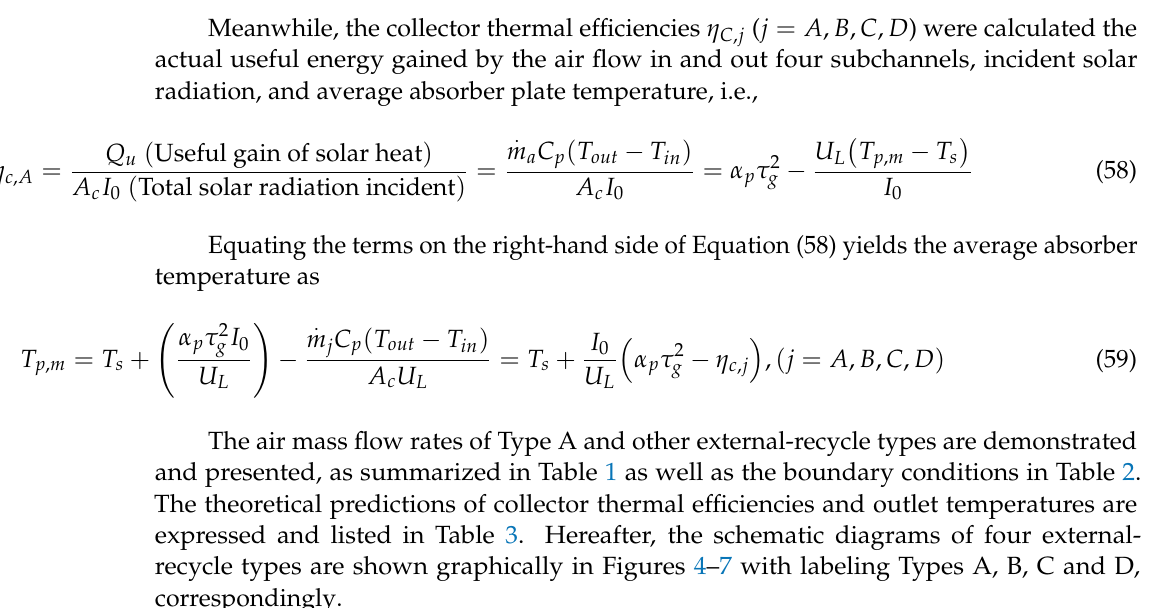
. m c Right-Hand Side